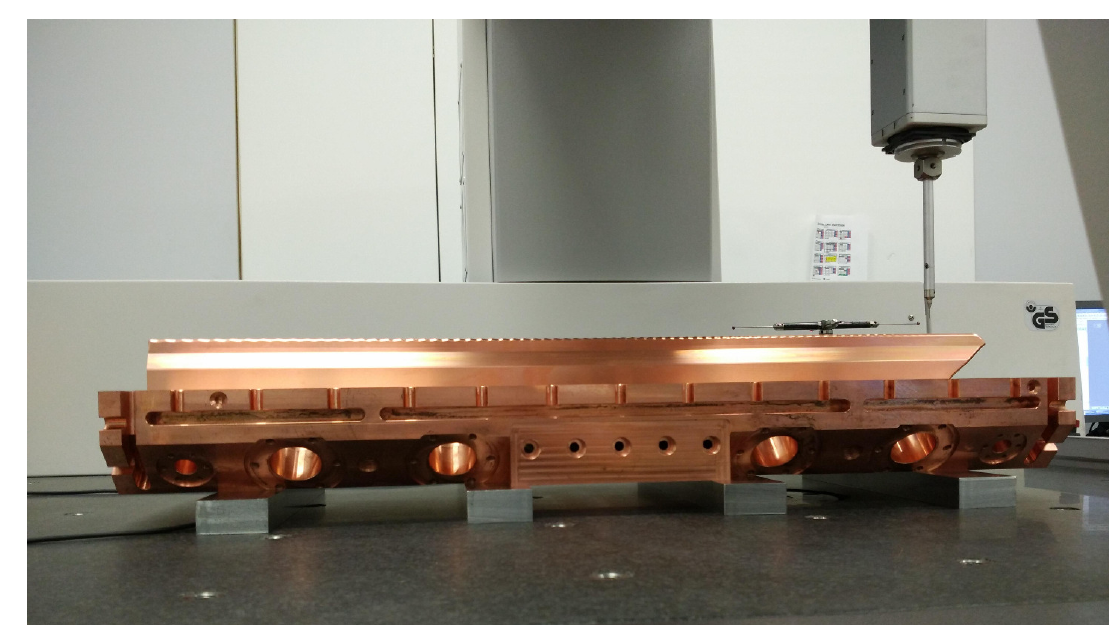
Figure 23. Major vane in the metrology station.